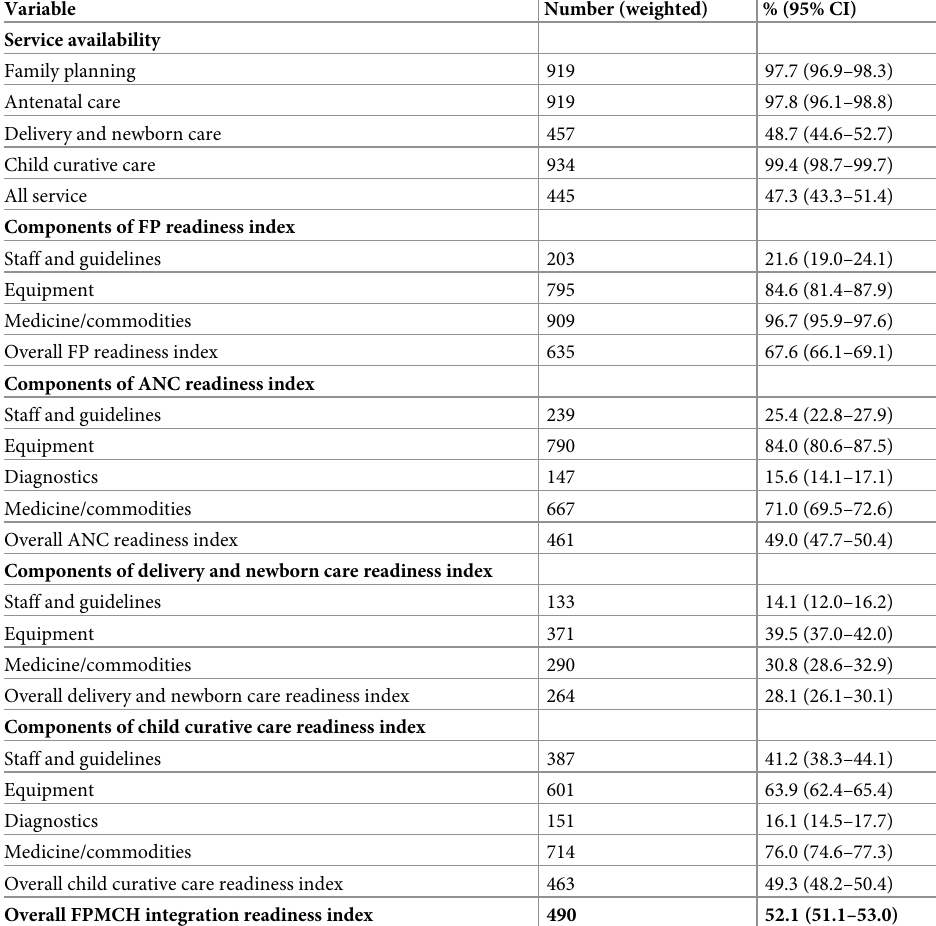
Table 2. Percentage distribution of health facilities with the availability and readiness to family planning, mater- nal and child health services (n =